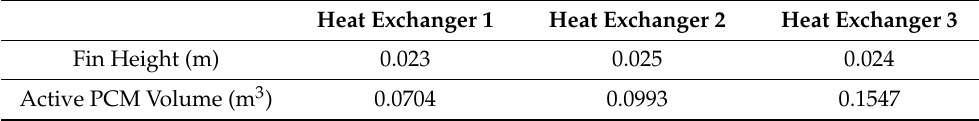
Table 4. Geometrical features of the computational model for the HE-discharging